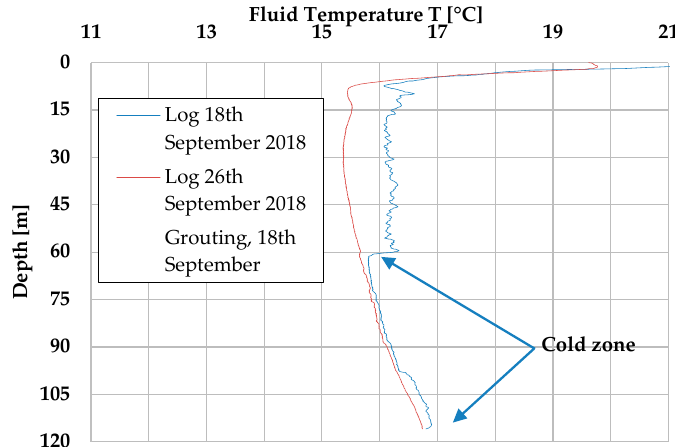
Figure 5. Vertical ground temperature profiles at the FAE-2 pilot BHE during the grout hydration period (24 January profile) as compared to the one at the end of the chemical reaction, 15 days later.